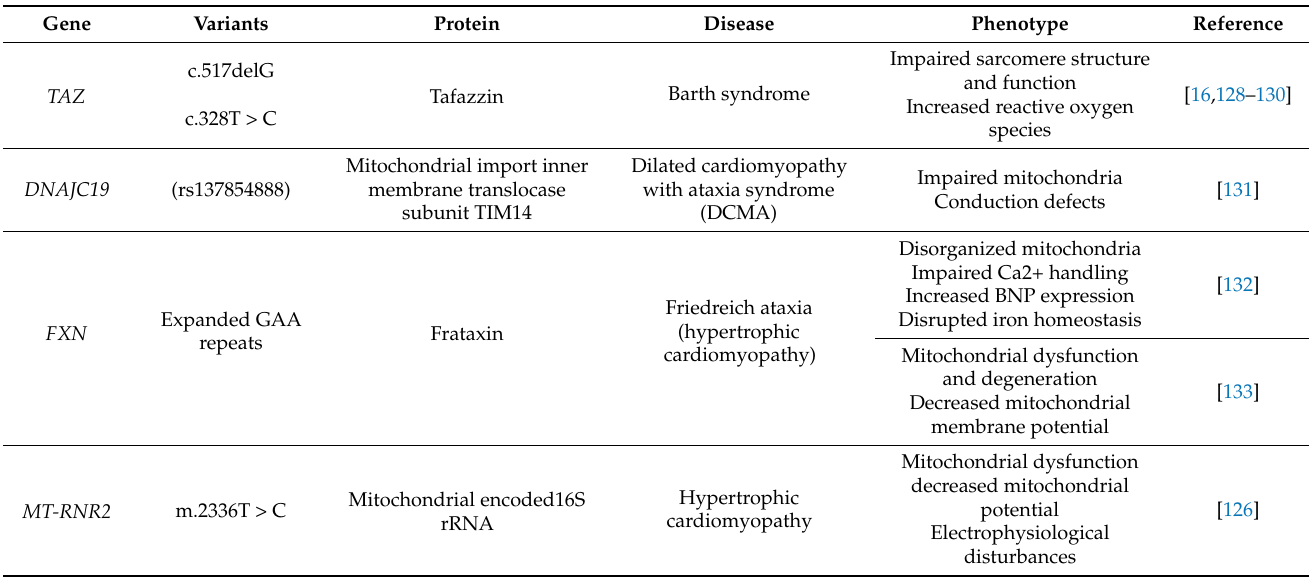
Table 2. List of mitochondrial diseases analyzed using